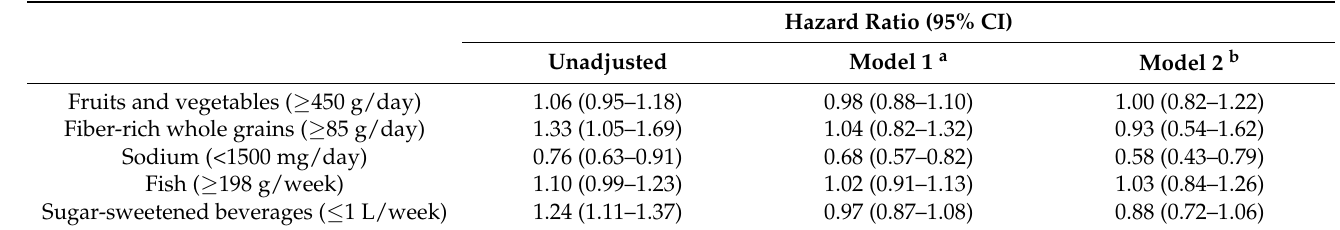
Figure 2. Hazard ratio for incident proteinuria between each component of cardiovascular health metrics. Table 4. Hazard ratio for incident proteinuria between each component of healthy diet